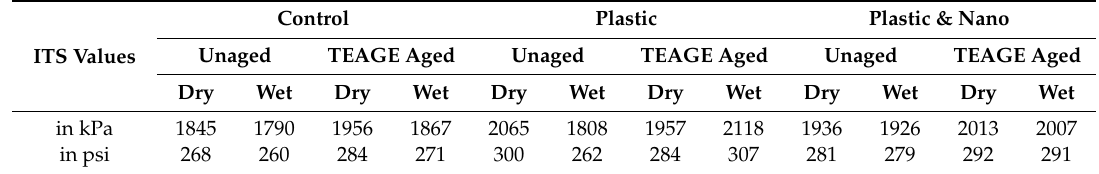
Table 1. Indirect tensile strength (ITS) values.